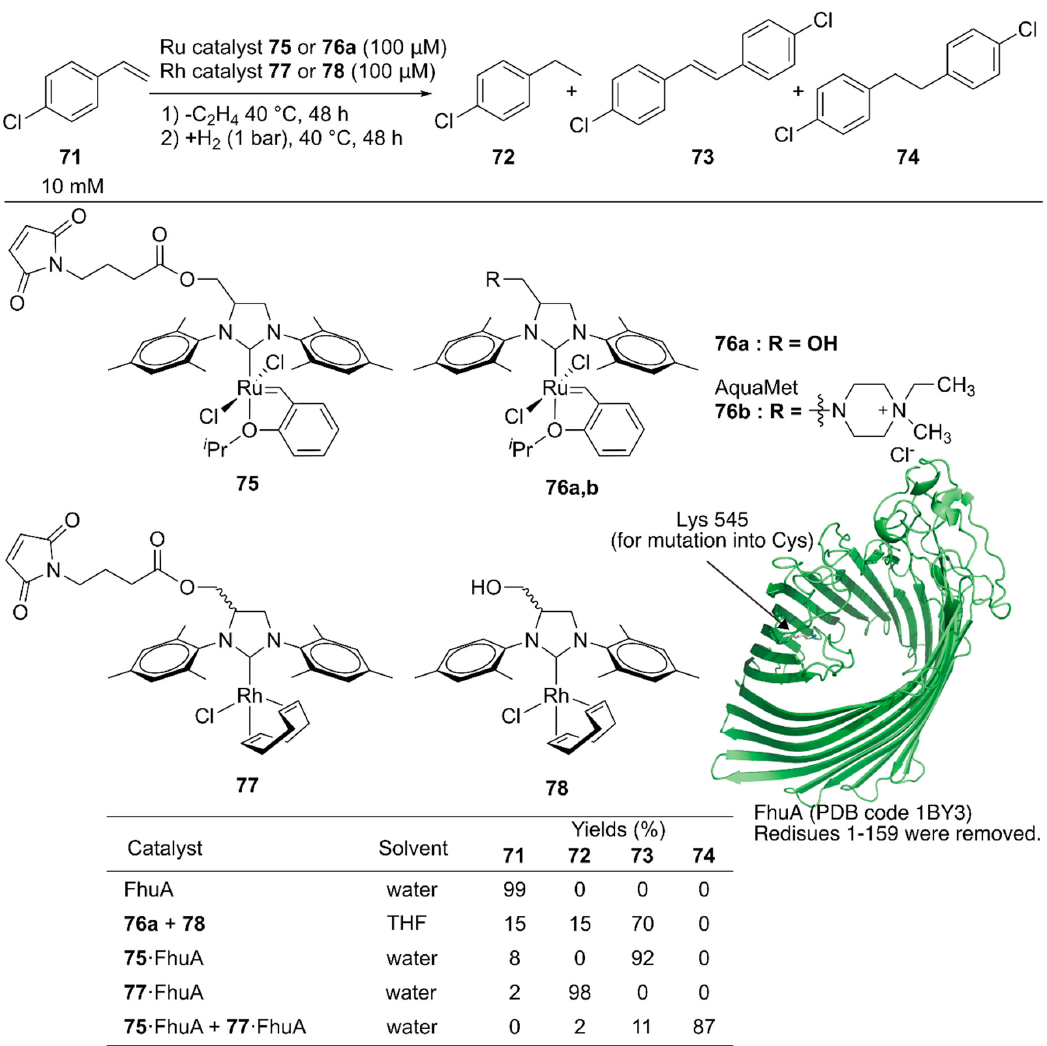
Figure 15. Cascade reactions involving olefin metathesis and subsequent hydrogenation catalyzed by Ru and Rh ArMs. Adapted from [111].